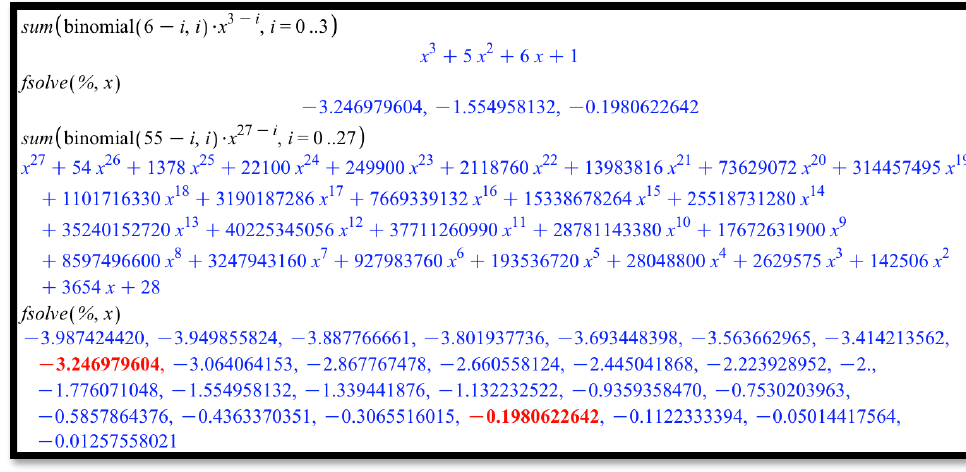
Figure 8. Illustrating Conjectures 1 and 2 when k = 7 and n =